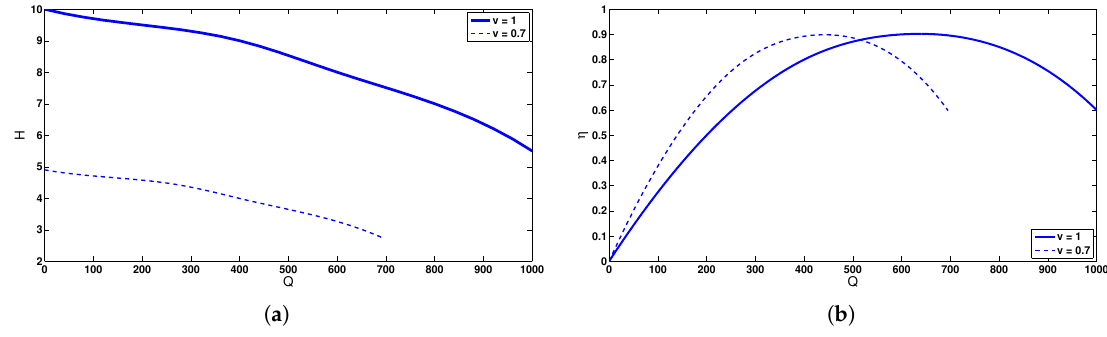
Figure 3. The characteristic curve in ( a ) and the efficiency curve in ( b ) are both scaled down from speed v = 1 to speed v =